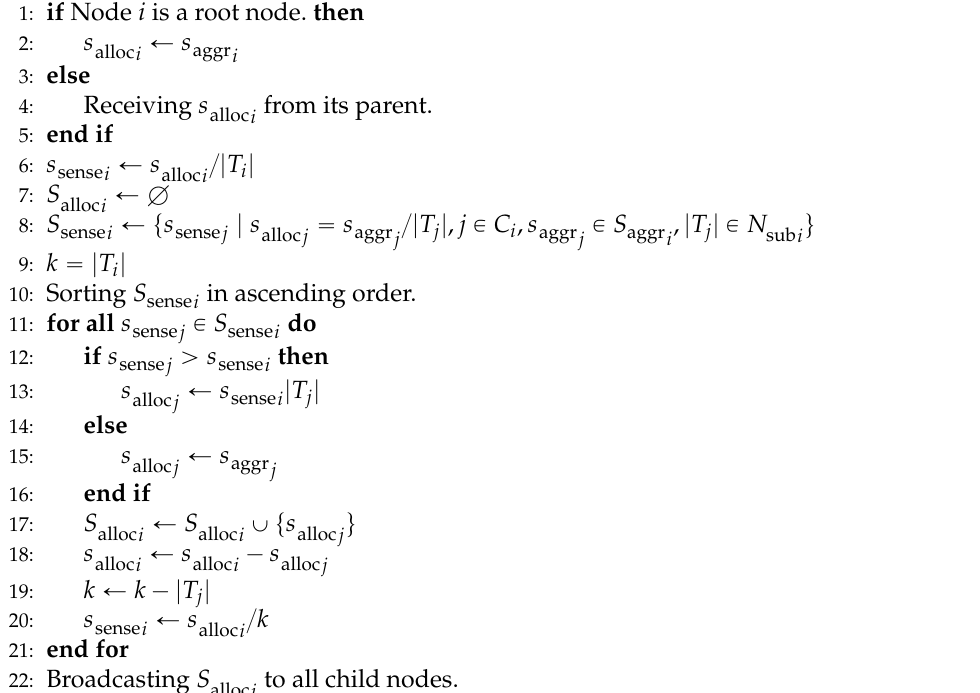
Algorithm 2 Broadcasting the amount of data allocated to all child